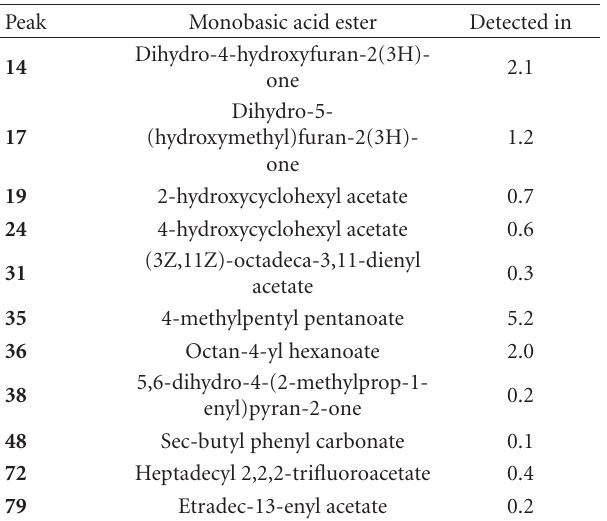
Table 3: Monobasicacidesters detected in the products from ASF ODVR .